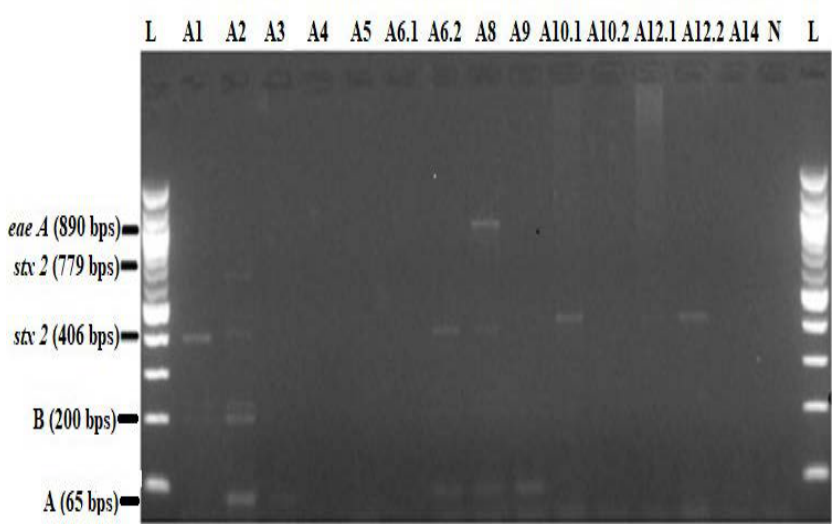
Fig. 2. Multiplex PCR of stx 1 , stx 2, eae A and hlyA gene in E. coli isolates. Arrows A and B refer to non-specific PCR bands. Lanes A1 – A14 are the 14 E. coli isolates. Each pair of lanes A6.1 and A6.2, A10.1 and A10.2, A12.1 and A12.2 refers to two E. coli isolates differentiated by the colour of the colony but in the same culture plate. The other 6 E.coli isolates were all negative (data not shown). Lane L = 100bp DNA ladder, Lane N = negative